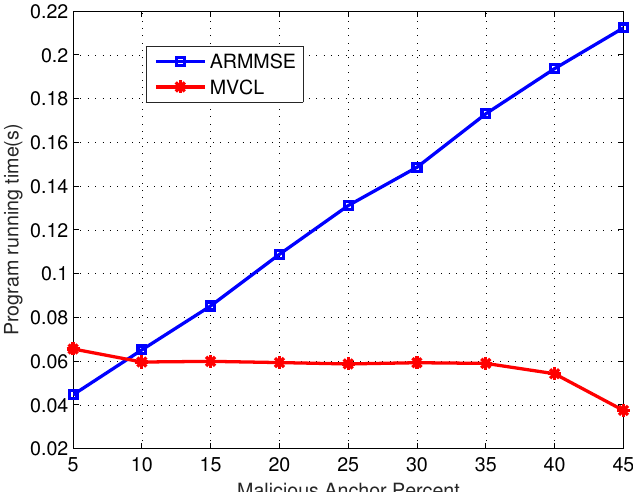
Figure 20. Operation time with malicious anchor percent p ( n = 80, m = 20, R = 30, k = 4, ζ = 15, η =